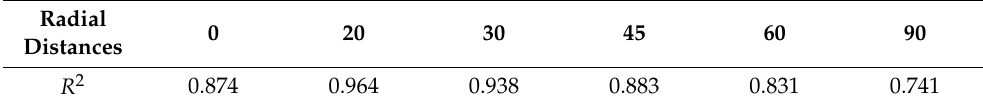
Table 4. Fitting results at each radial distance.